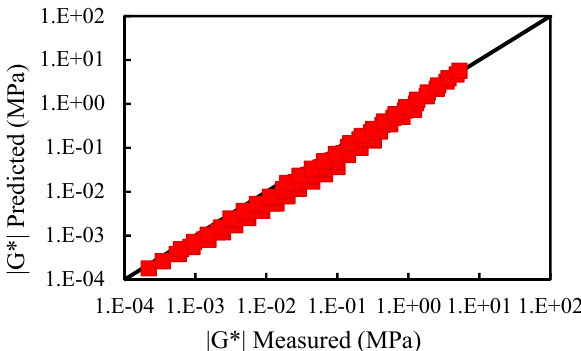
Figure 12. Comparison between the measured complex modulus of ZH70 (0.38A) with the predicted.